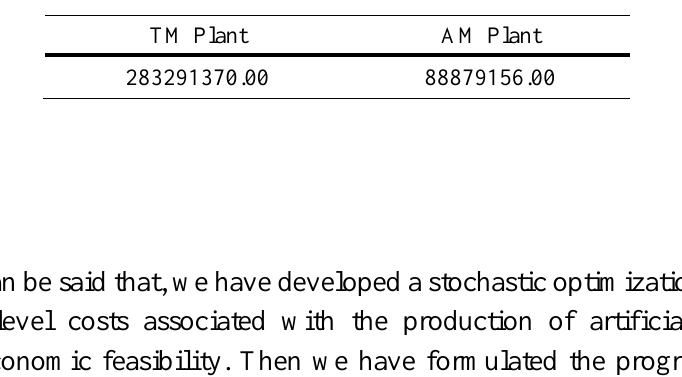
Table 3. MIP solution of total supply chain